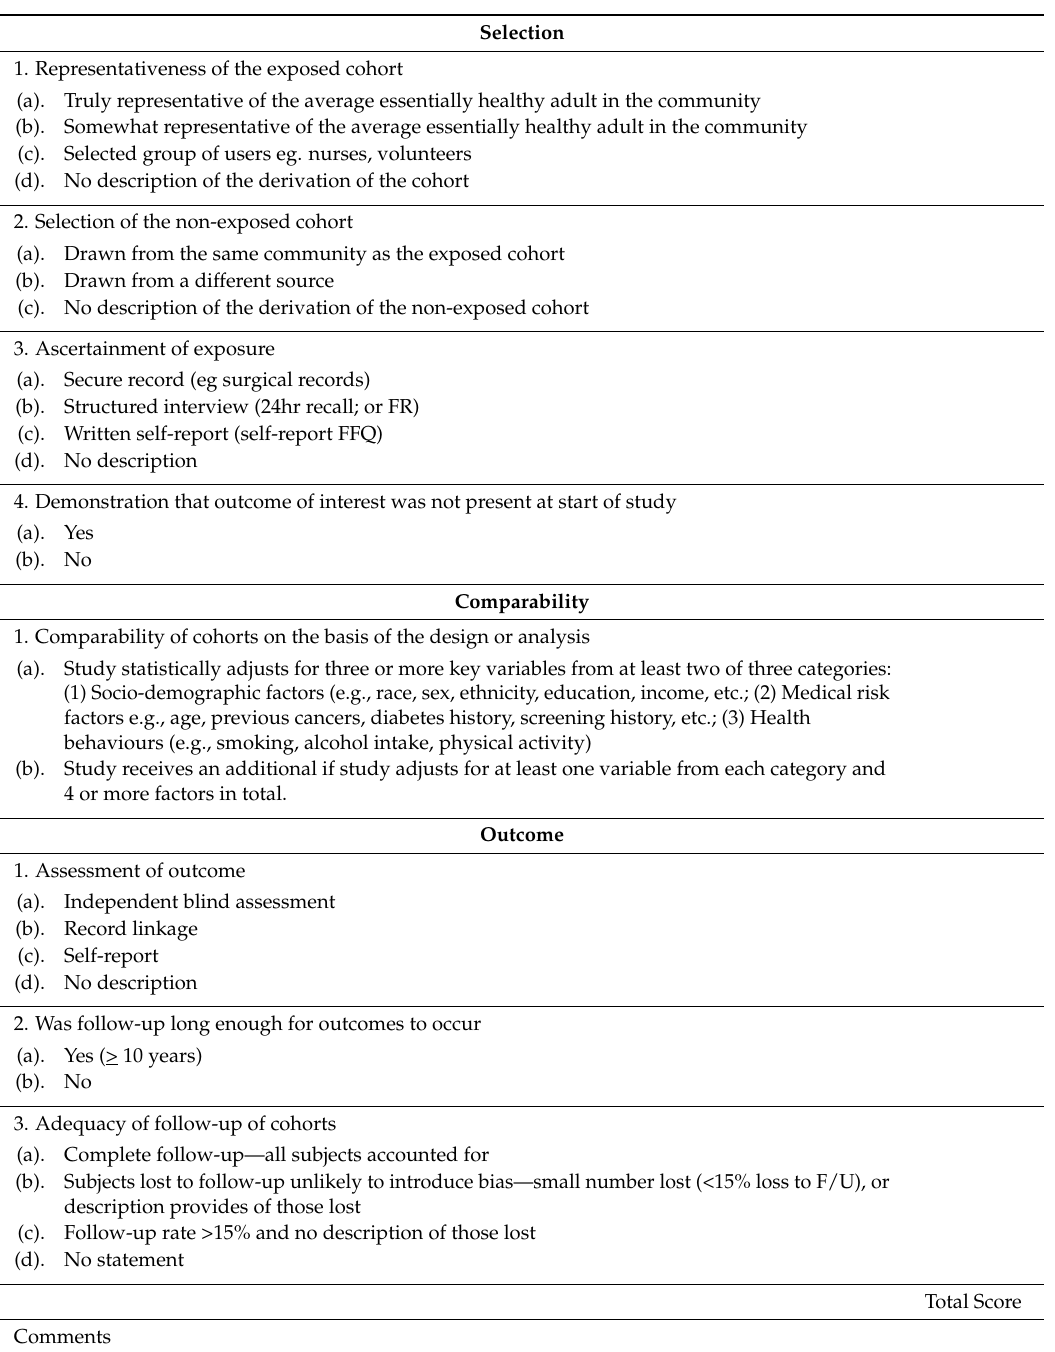
Table A1. Newcastle—Ottawa quality assessment